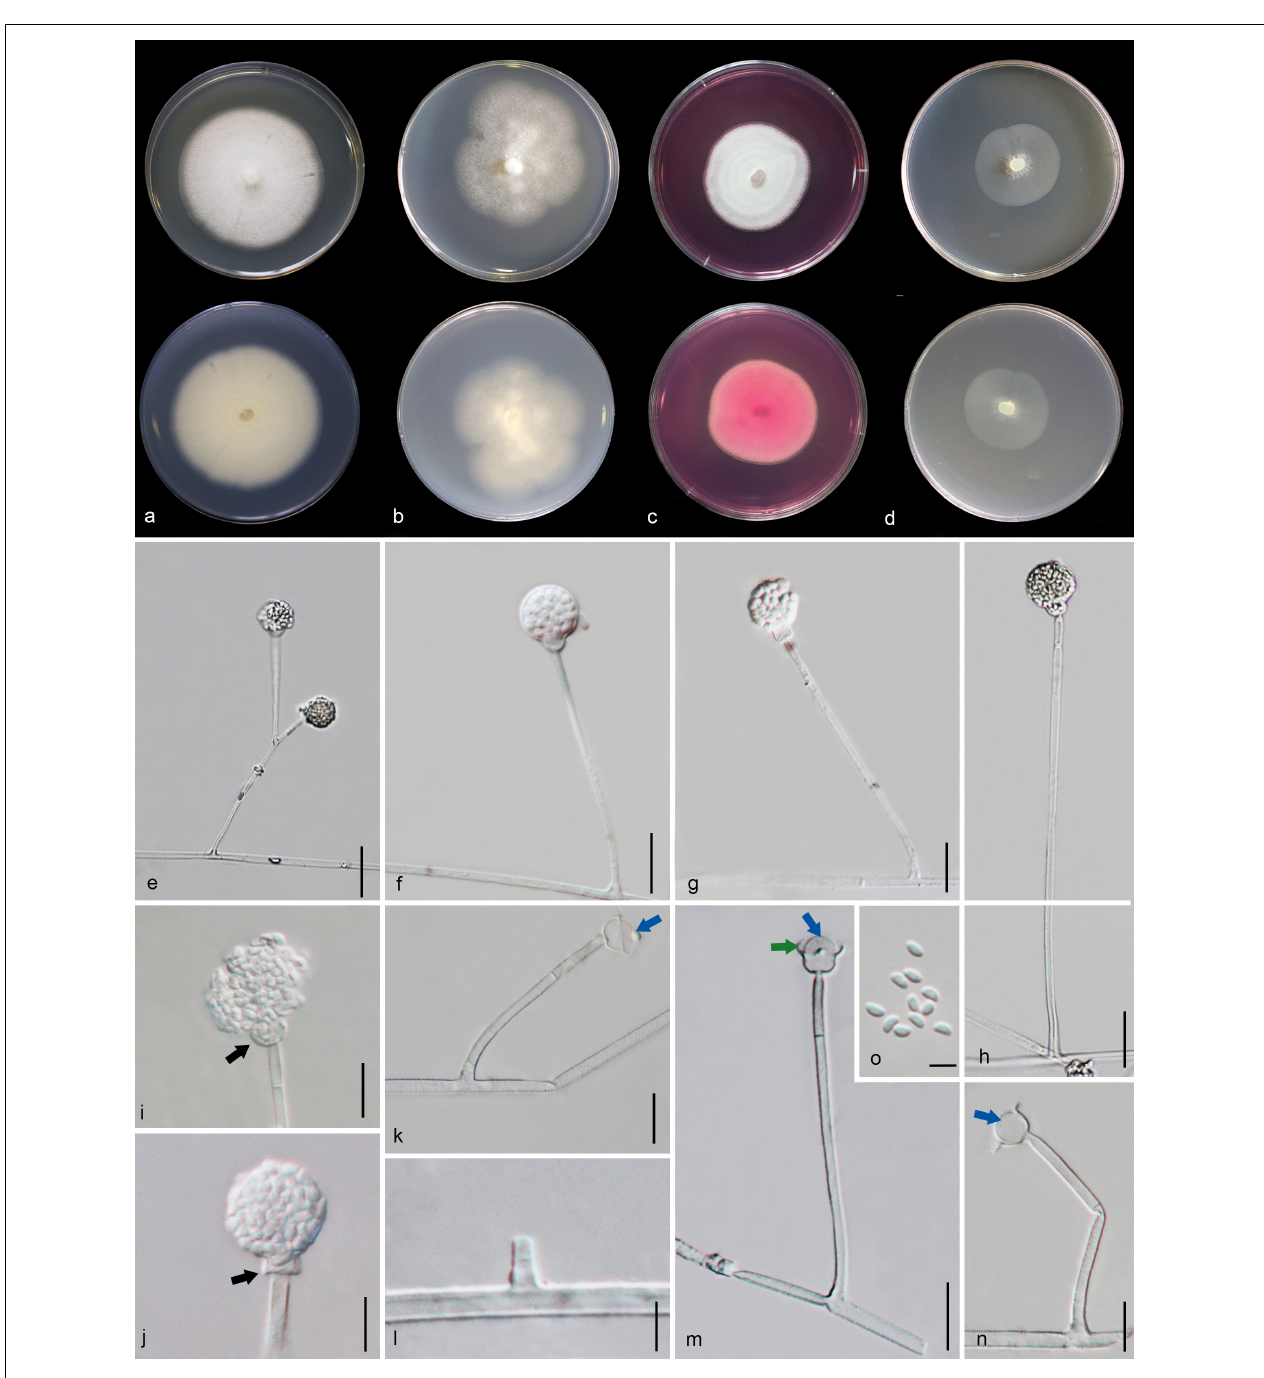
FIGURE 8 | Gongronella hydei (MFLU 20-0431, holotype). (a–d) Colonies on PDA, CYA, rosebengal and WA at 25 ◦ C, respectively. (e) Branched sporangiophore with sporangia. (f–h) Sporangiophores with sporangia and apophyses. (i,j) Aggregated sporangiospores in sporangia with variously shaped apophysis (black arrows). (k,m,n) Septate sporangiophores with apophyses, columella (blue arrows) and collarette (green arrow). (l) Developed sporangiophore from hypha. (o) Sporangiospores. Scale bars: (e,h) = 20 µ m, (f,g,i–n) = 10 µ m, (o) = 5 µ m.